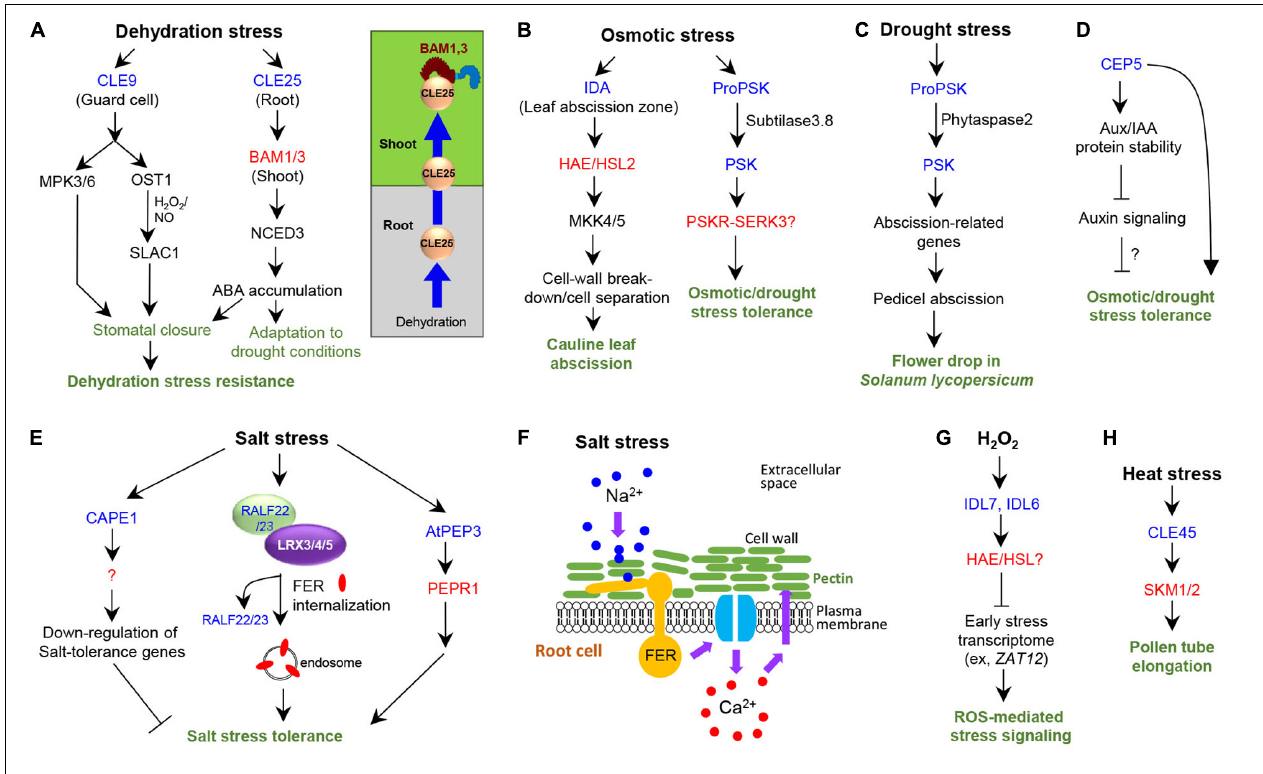
FIGURE 1 | Signaling peptides control abiotic stress responses in plants. Blue and red letters indicate peptides and the cognate receptors, respectively. Plant not specified in the subtitle indicates Arabidopsis . (A) Roles and signaling pathways of CLE9/25 in dehydration stress response. (B) Roles and signaling pathways of IDA and PSK in osmotic stress response. (C) Roles of PSK in flower abscission in tomato under drought stress. (D) Role of CEP5 in osmotic and drought stress tolerance. (E) Roles and signaling pathways in high salinity stress response. (F) Role of FER receptor kinase during high salinity stress response to maintain cell-wall integrity in root cells. (G) Role of IDL6/7 in ROS-mediated stress signaling. (H) Role of CLE45 in pollen tube elongation under heat